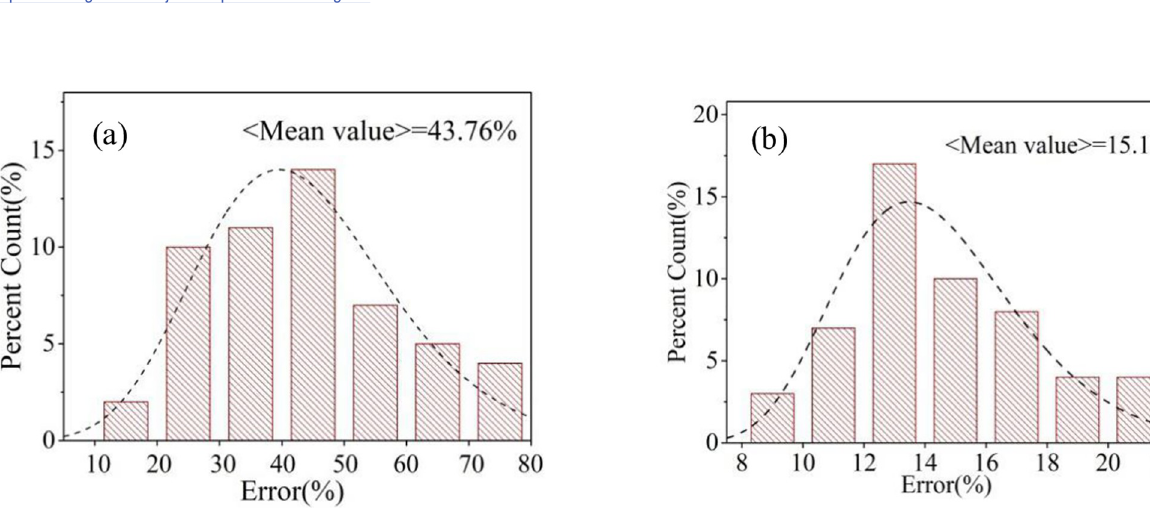
PLOS ONE | https://doi.org/10.1371/journal.pone.0274236 September 16, 2022 16 /